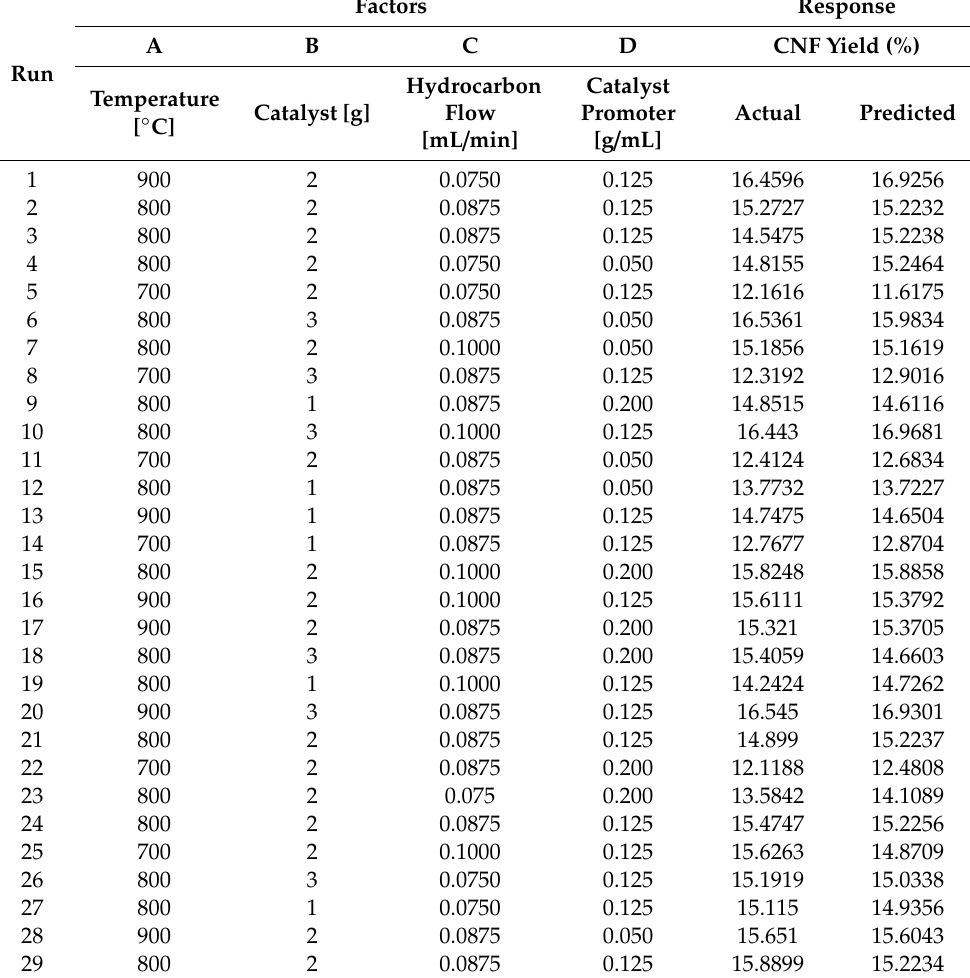
Table 2. Experimental matrix of four-level factorial plan in the RSM